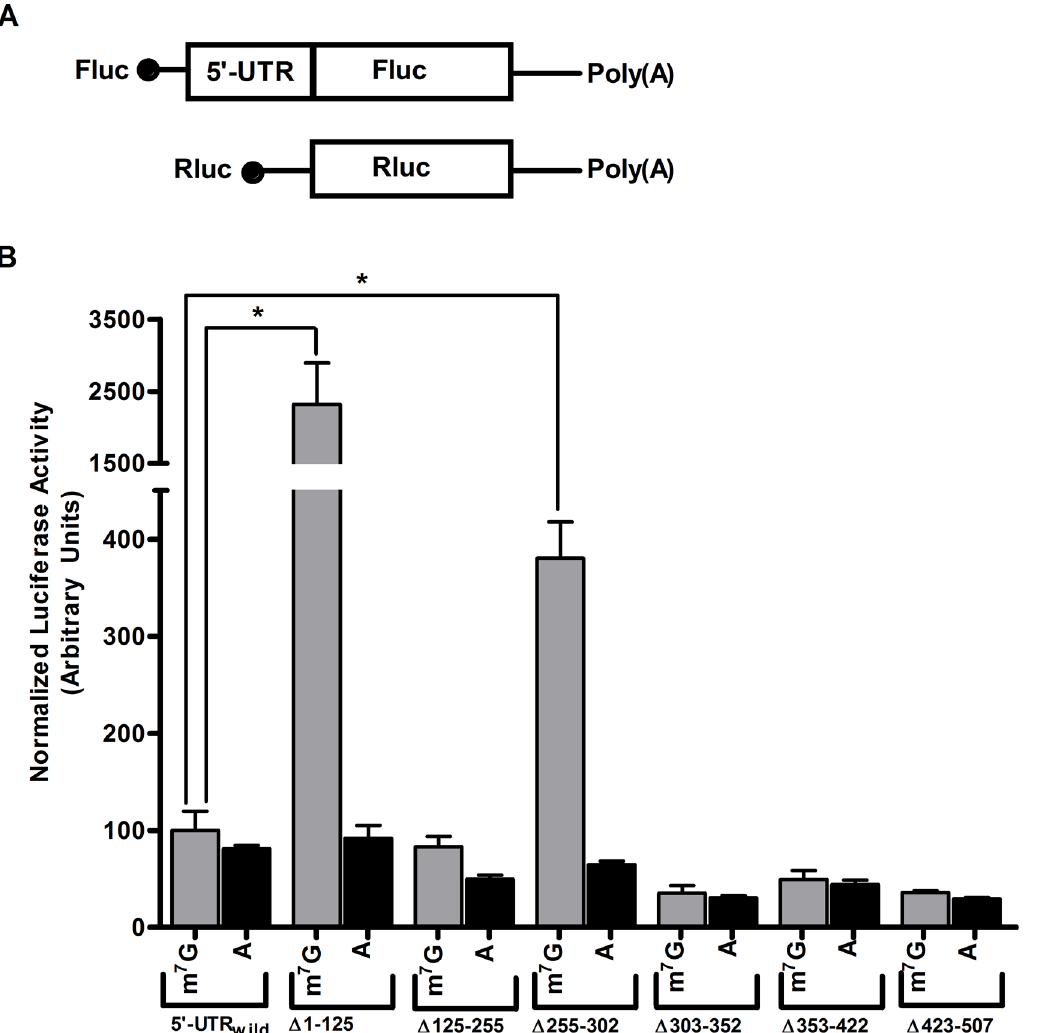
Fig 3. Deletion analysis of utrophin-A 5'-UTR for identification of repressor elements. (A) Schematic presentation of monocistronic mRNA pairs used in the assay. Fluc: Firefly luciferase, Rluc: Renilla luciferase. To normalize activities of m7G-capped and A-capped Fluc constructs containing the tested 5'- UTRs, the m7G-capped Rluc was used as reference. (B) Equimolar amount of m7G-capped and A-capped monocistronic transcripts were used in the RNA transfection assay with mouse C2C12 cells. Wild and Δ denote full length and deletion respectively. Results presented as mean ± SD (n = 6). Student ’ s t test was used to analyze the data. The asterisks denote the statistically significant (P < 0.0001) difference in relative luciferase activity of m7G-capped transcripts. Deletion of 1 – 125 nt and 255 – 302 nt upregulated m7G-cap-dependent expression. No deletion upregulated expression of A-capped